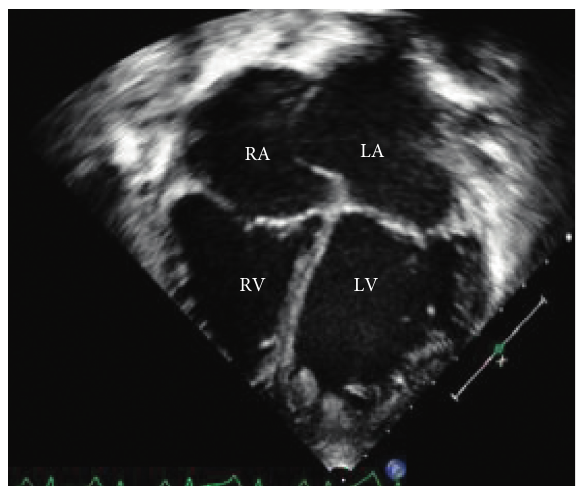
Figure 1: Apical four chamber view showing bilateral atrial and ventricular dilation with anterior bowing of the interatrial septum suggestive of elevated left atrial pressure. There are also prominent hypertrabeculations at the apex of the left ventricle. LA: left atrium. LV: left ventricle. RA: right atrium. RV: right ventricle.